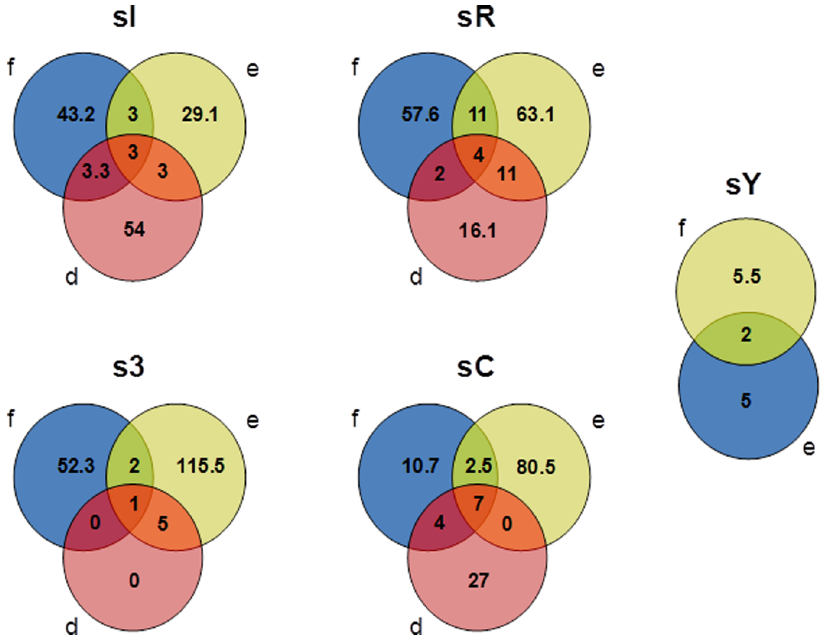
Figure 2. A Venn diagram of alkB clone libraries using a distance level of 97% similarity. The numbers represent the richness and the shared richness of each library using the Chao richness index [28]. The Venn diagram groups are denoted as follows: sI, sR, sY, s3 and sC represent the sampling sites, and the letters (d), (e) and (f) correspond to the alkB -targeting primers used in the PCR amplification of the alkB gene, as described in Table